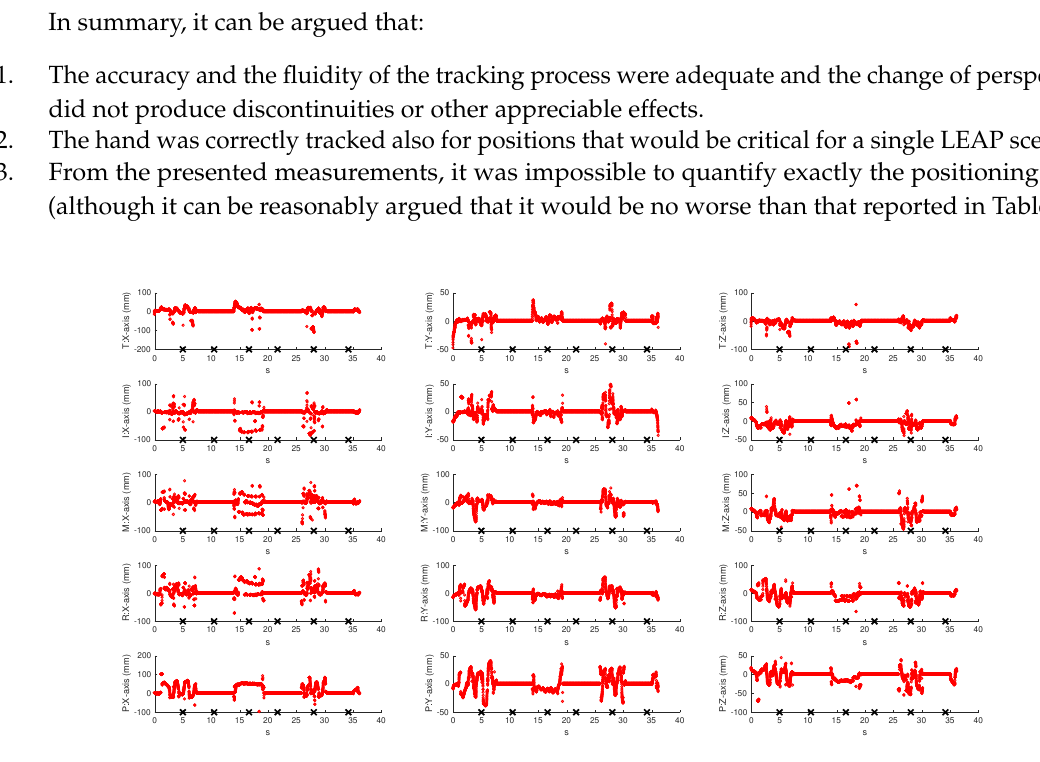
Figure 9. Differences between VG tracking measurements and vertical LEAP measurements for each finger (T: thumb; I: index; M: middle; R: ring finger; and P: pinkie) and for each